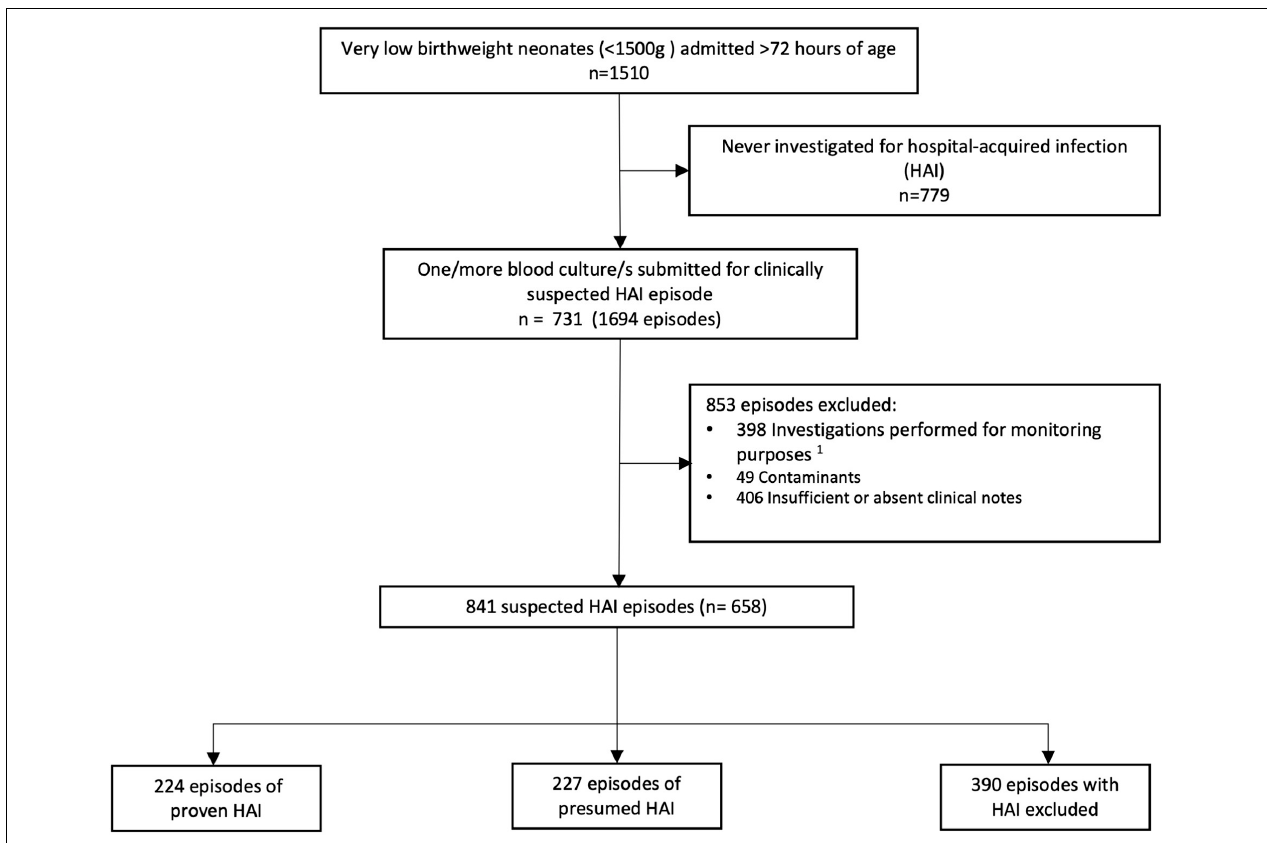
FIGURE 1 | Flow diagram of neonatal hospital-acquired infection episodes in very low birth weight infants included in the analysis. 1 Monitoring purposes: this refers to blood culture/s performed after 72 h of life in response to a positive blood culture or raised CRP obtained < 72 h of life to monitor response to antimicrobial